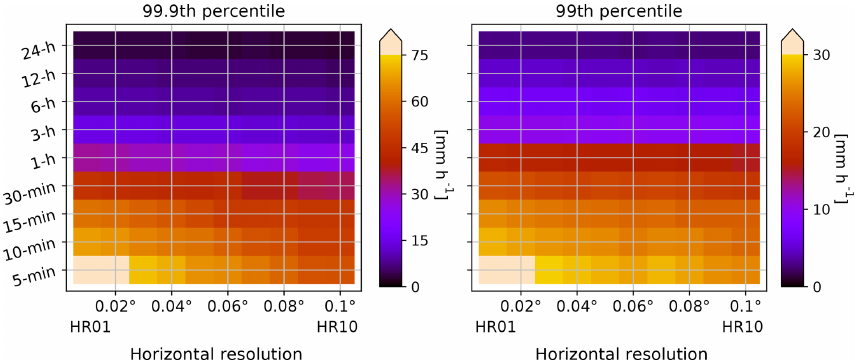
Figure 11. 99.9th and 99th percentiles of rainfall intensities derived from gridded rainfall fields with different spatial and temporal scales. Note the different color scale for the